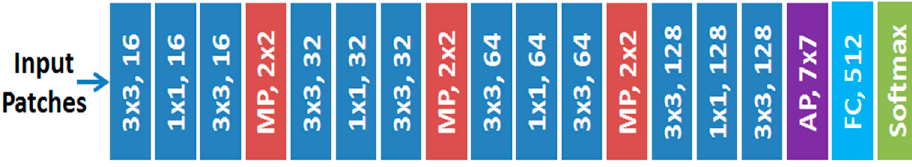
Figure 6. Flowchart of Lesion Feature Network (LFN).